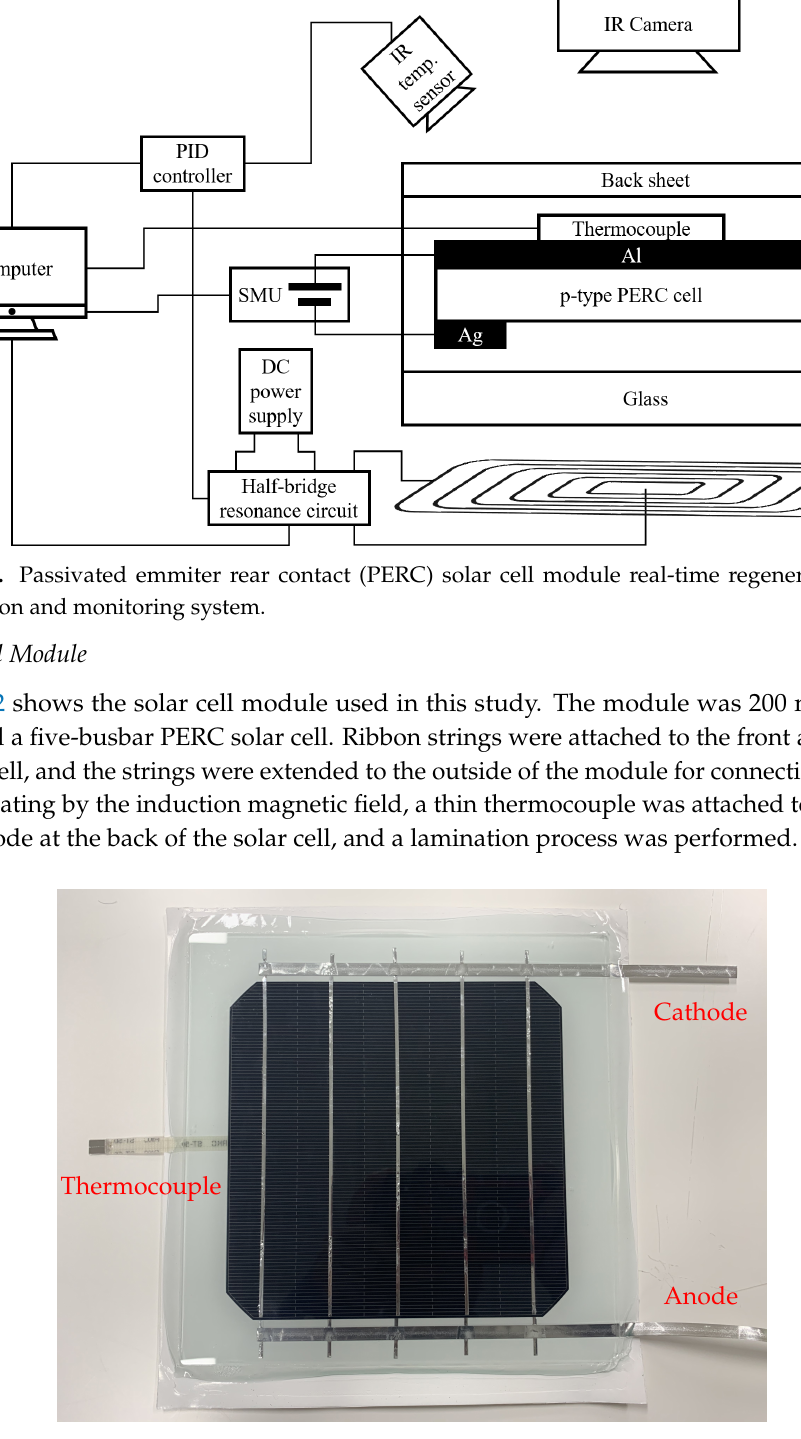
Figure 2. Small-area module specimen for experiment on applying regeneration state to PERC solar cell